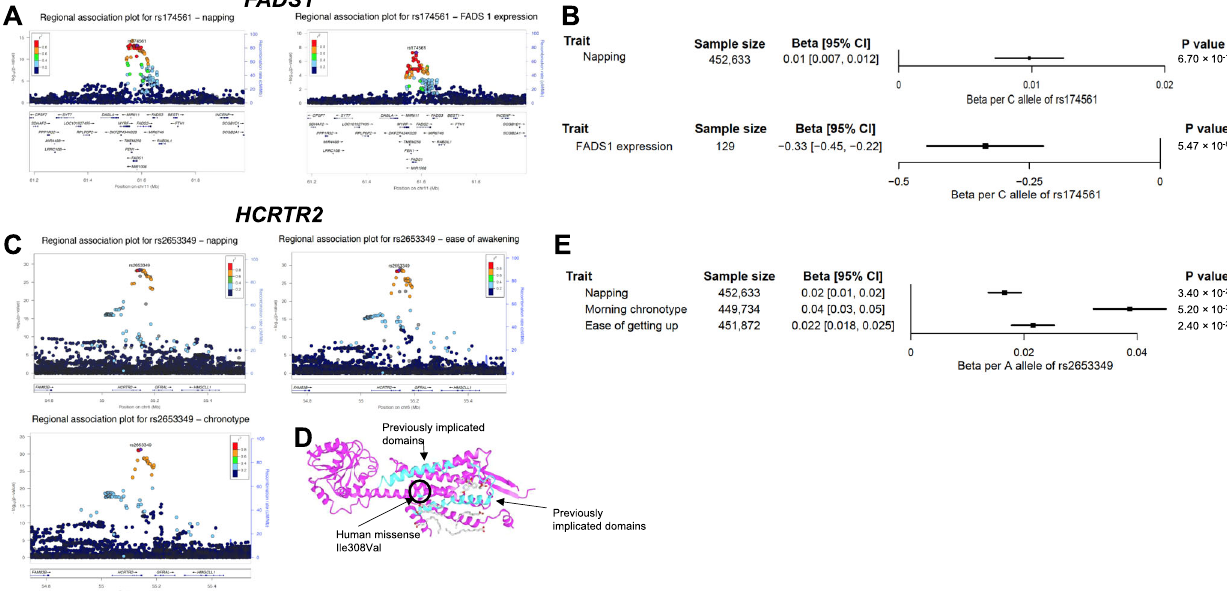
Fig. 2 Colocalization analysis reveals a shared causal variant reducing FADS1 gene expression in the frontal cortex and increasing napping liability, and a shared causal missense variant in HCRTR2 in fl uencing daytime napping, chronotype, and ease of awakening. A Regional association plots for daytime napping and FADS1 gene expression in the frontal cortex at rs174561 and variants within 400 kb on chromosome 11. The y -axis shows the − log 10 P value for each variant in the region, and the x -axis shows the genomic position. Each variant is represented by a fi lled circle, with the rs174561 variant colored purple, and nearby variants colored according to degree of linkage disequilibrium ( r 2 ) with rs174561. The lower panel shows genes located in the displayed region and the blue line corresponds to the recombination rate. B Forest plot of associations between the C allele of genetic variant rs174561 in FADS1 with daytime napping and gene expression of FADS1 in the frontal cortex. Units of daytime napping re fl ect an increase on the ordinal scale of the trait, and gene expression is in standard deviation units. P values are two-sided and were obtained using linear regression. Black box indicates the effect estimate and lines represent 95% con fi dence intervals. C Regional association plot for colocalized sleep phenotypes at rs2653349 and variants within valine at the transmembrane domain of HCRTR2. Protein sequence was visualized using iCn3D (https://www.ncbi.nlm.nih.gov/Structure/icn3d/full.html). The variant rs2653349 was aligned with the sequence (arrows to Human Missense variant in Figure) and the previously published canine HCRTR2 mutations 105 , which disrupt transmembrane and signaling domains or truncate the HCRTR2 protein are highlighted in cyan. E Forest plot of associations between the A allele of genetic variant rs2653349 in HCRTR2 and the colocalized sleep phenotypes. P values are two-sided and were obtained using linear regression. Black boxes show effect estimates, and surrounding lines display 95% con fi dence score of the 123 napping variants, and polygenic sub-scores for each of the 3 clusters with cardiometabolic traits from large-scale public GWAS (Table 1, Supplementary Table 11). Cluster-speci fi c polygenic score associations varied across outcomes, and included associations of cluster 1 with higher blood pressure, and clusters 2 and 3 with adiposity traits (Table 1).